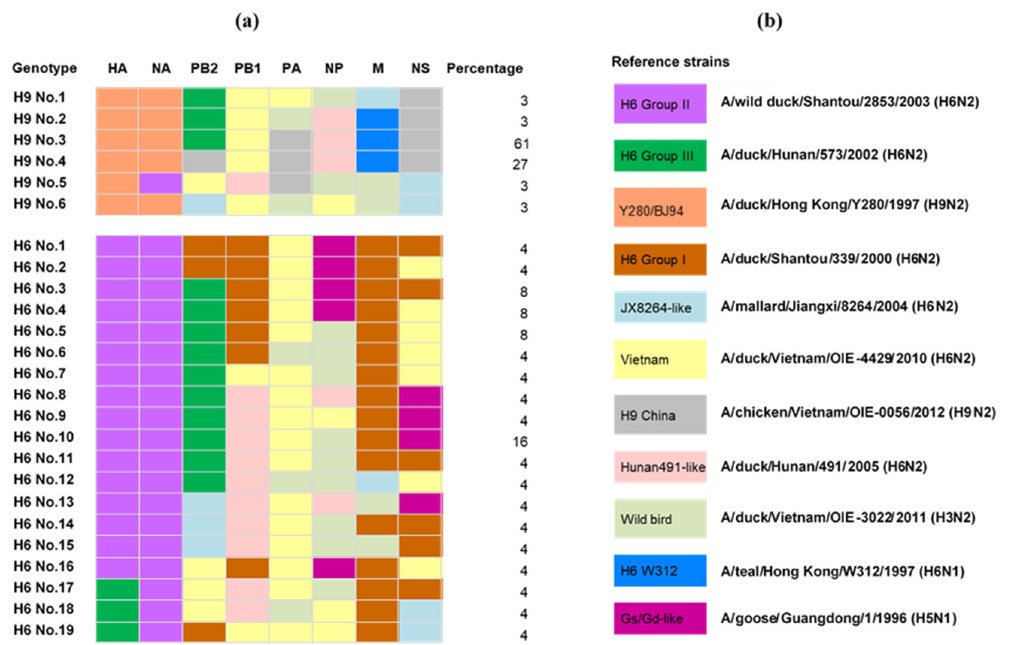
Figure 3 . The gene constellations of H6 and H9 avian influenza viruses isolated from poultry in Vietnam. ( a ) Different colors indicate segments whose sequences fall into different major clades clustered. ( b ) The representative strains of phylogenetic analysis.